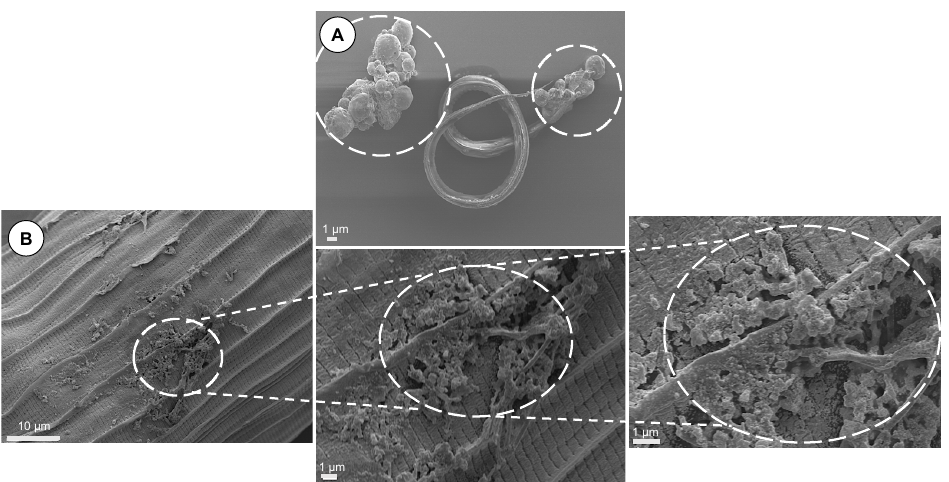
Figure 15. SEM micrographs of parasites treated with CS-PLGA particles loaded with combined EO components. The particles are deposited on the cuticular surface of ( A ) larva and ( B ) adult worm.